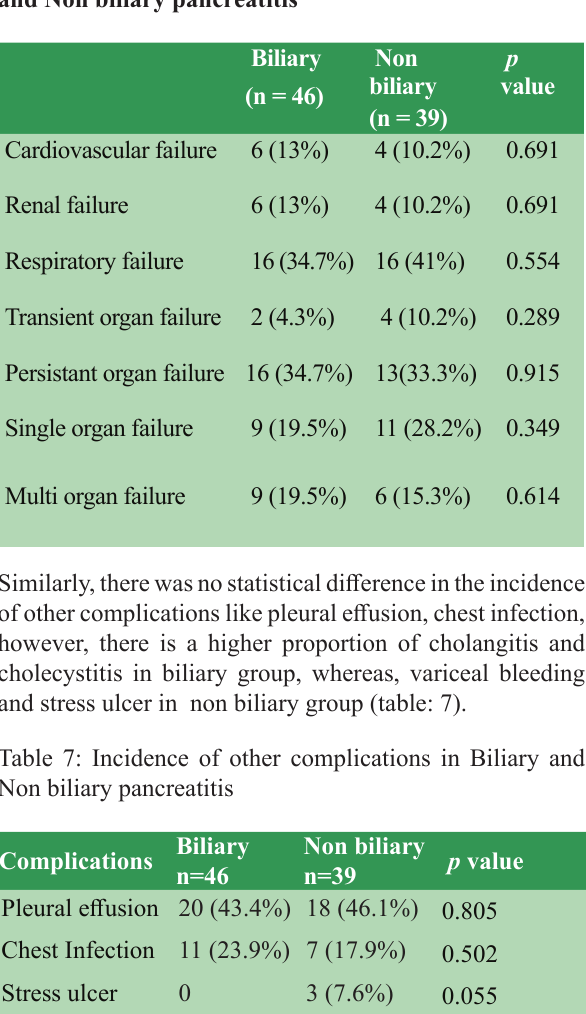
Table 8: Total no. of Interventions done in Biliary